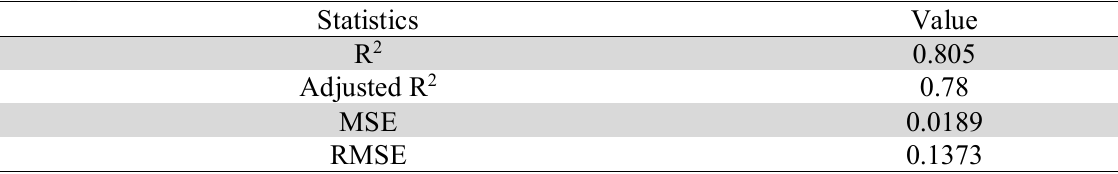
Model performance